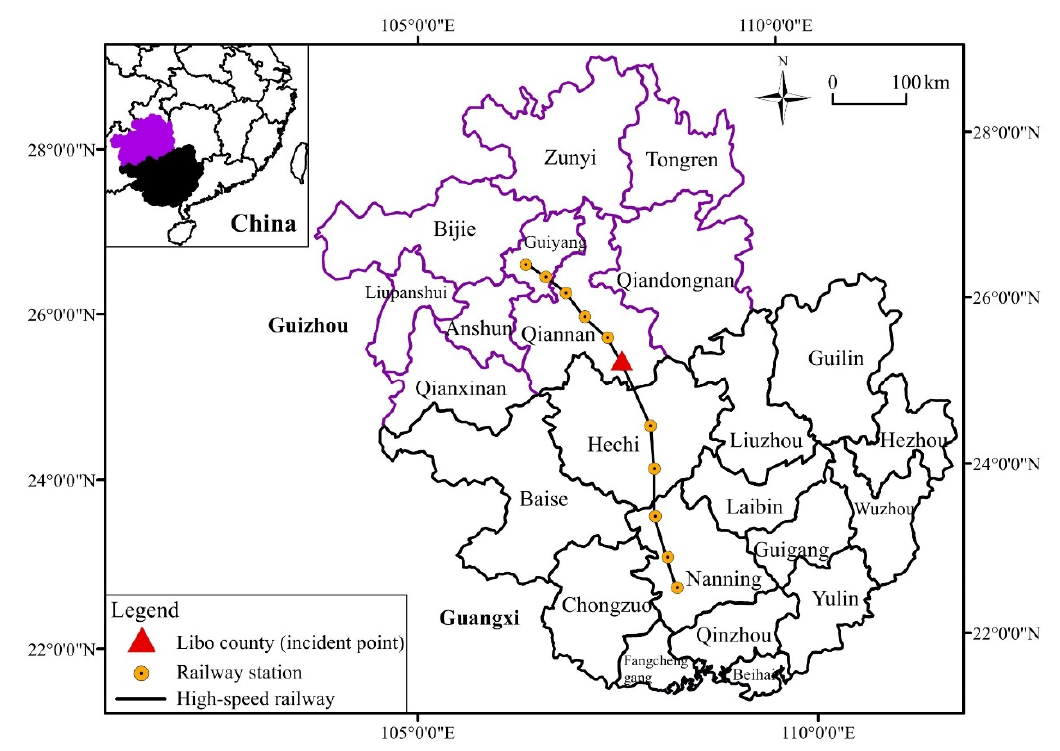
Figure 1. Location of water inrush incident along project line.